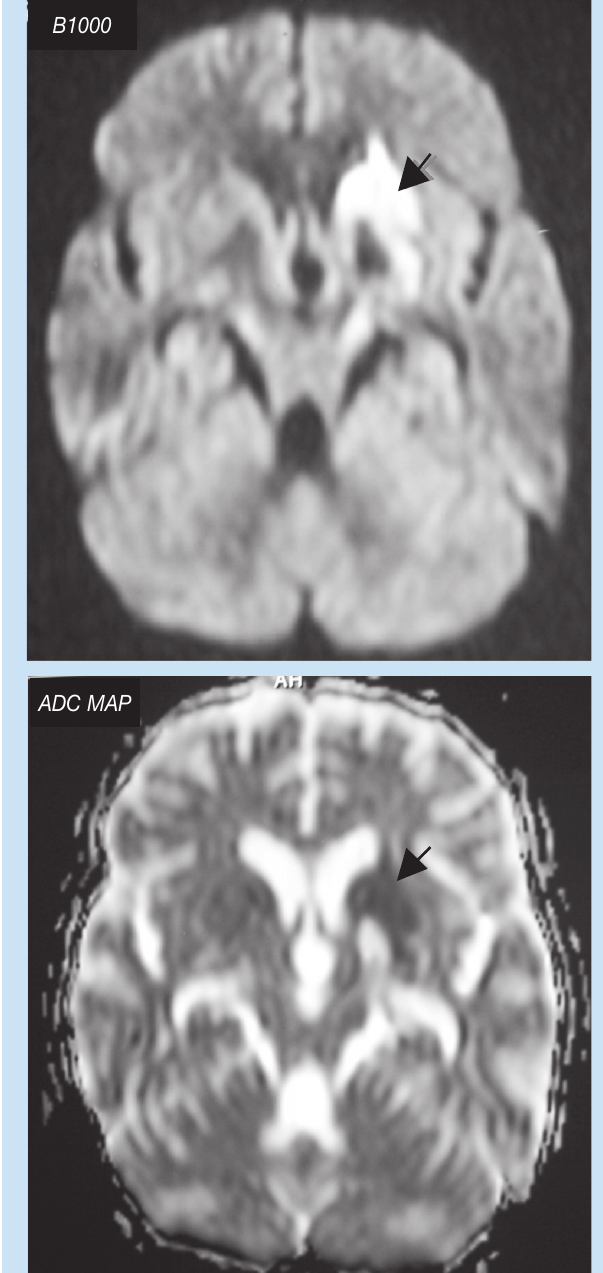
Fig. 4. MRI diffusion weighted imaging (DWI) sequence, B 1000 sequence showing a high signal intensity in the left caudate nucleus, with a corresponding low signal intensity on the Apparent Diffusion Coefficient (ADC) map, suggestive of a recent infarct. The region cor- responding to the old infarct of the lentiform nucleus has low signal intensity on the B1000 and high signal intensity on the ADC